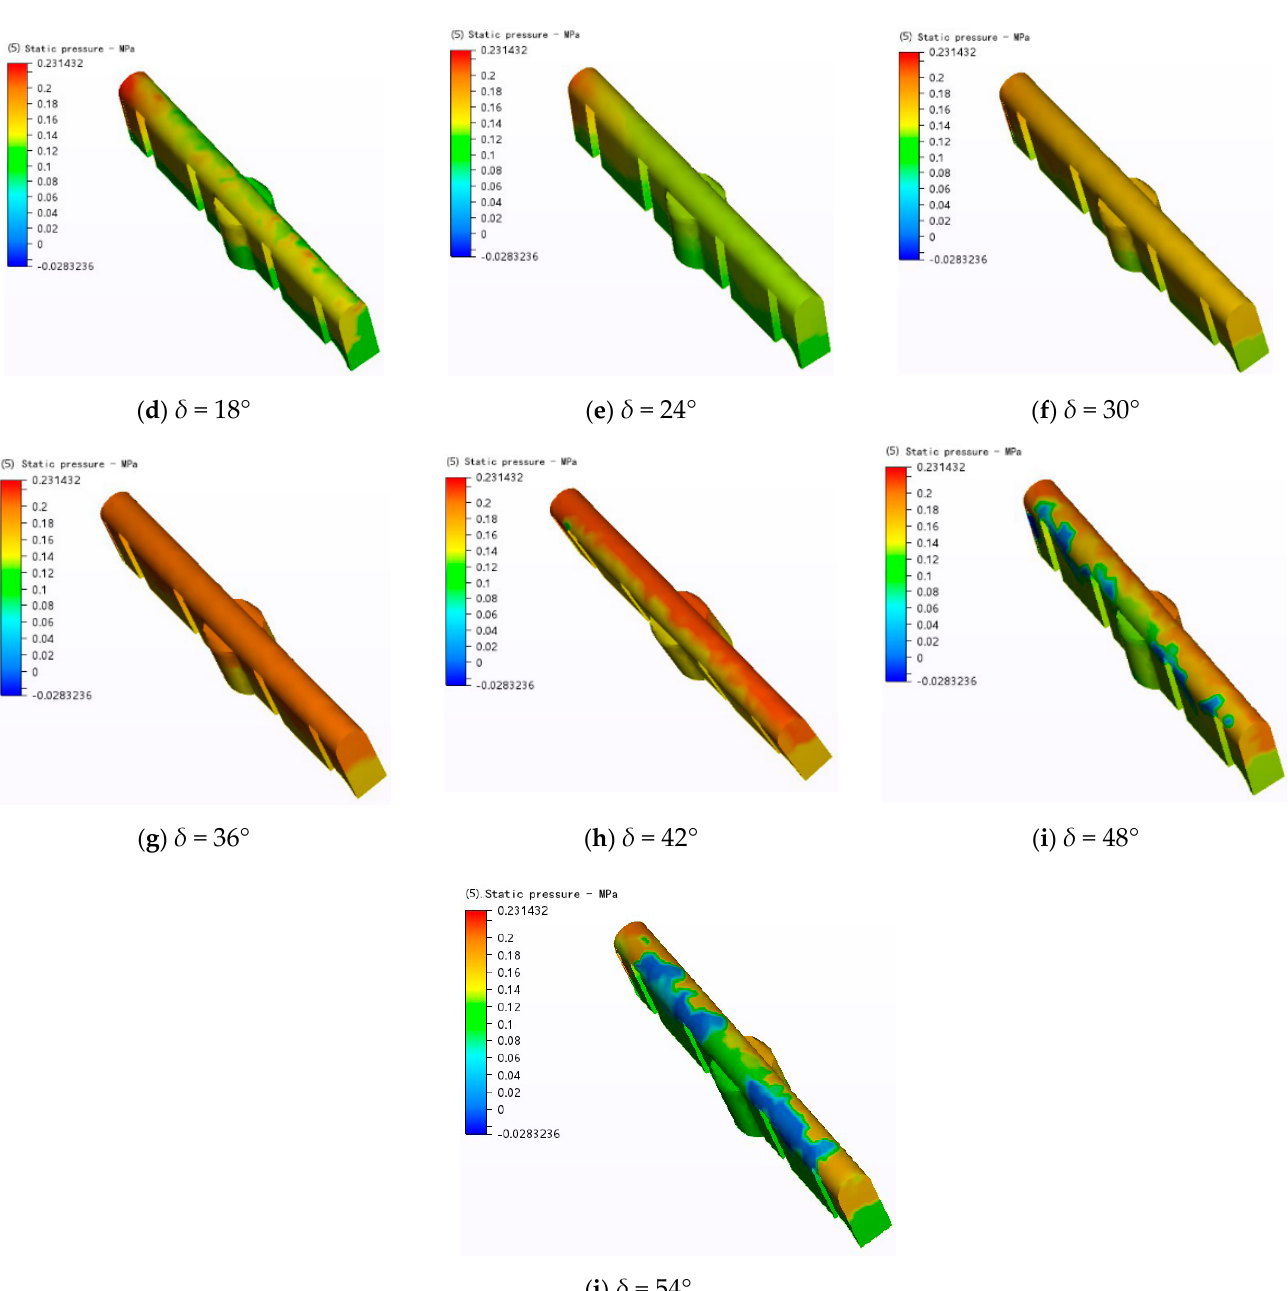
Figure A1. Fluid pressure nebulae of the model with different slide angles. The force cloud diagram of the hydraulic pressure section of the slide in the transition curve cavity section is shown in Figure A2.